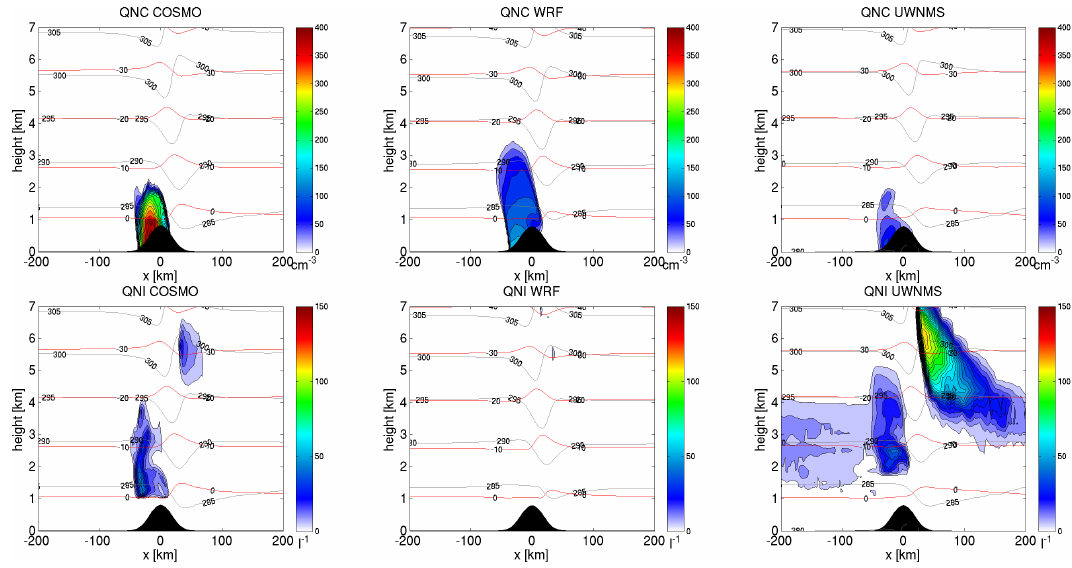
Fig. 7. Same as Fig. 4 but for the polluted case simulation SIM 1 PC.